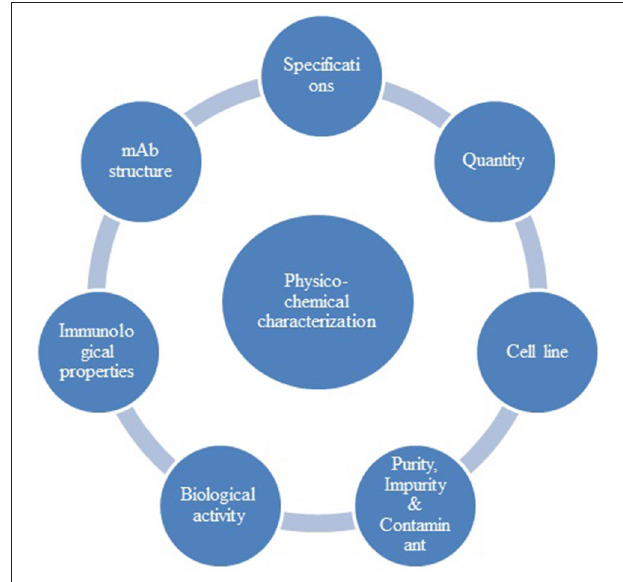
FIGURE 2 | Monoclonal antibodies-Physiochemical characterization